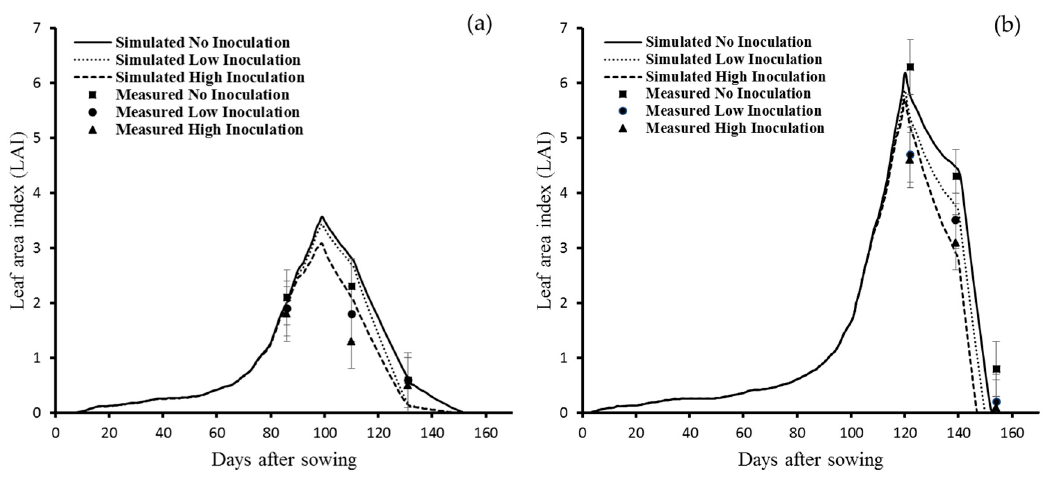
Figure 4. Simulated and measured leaf area index values for cultivar K. Chaja, year 2010 ( a ) and 2011 ( b ) including different inoculation treatments with septoria tritici blotch (STB). The error bars demonstrate the LSD of the leaf area index.